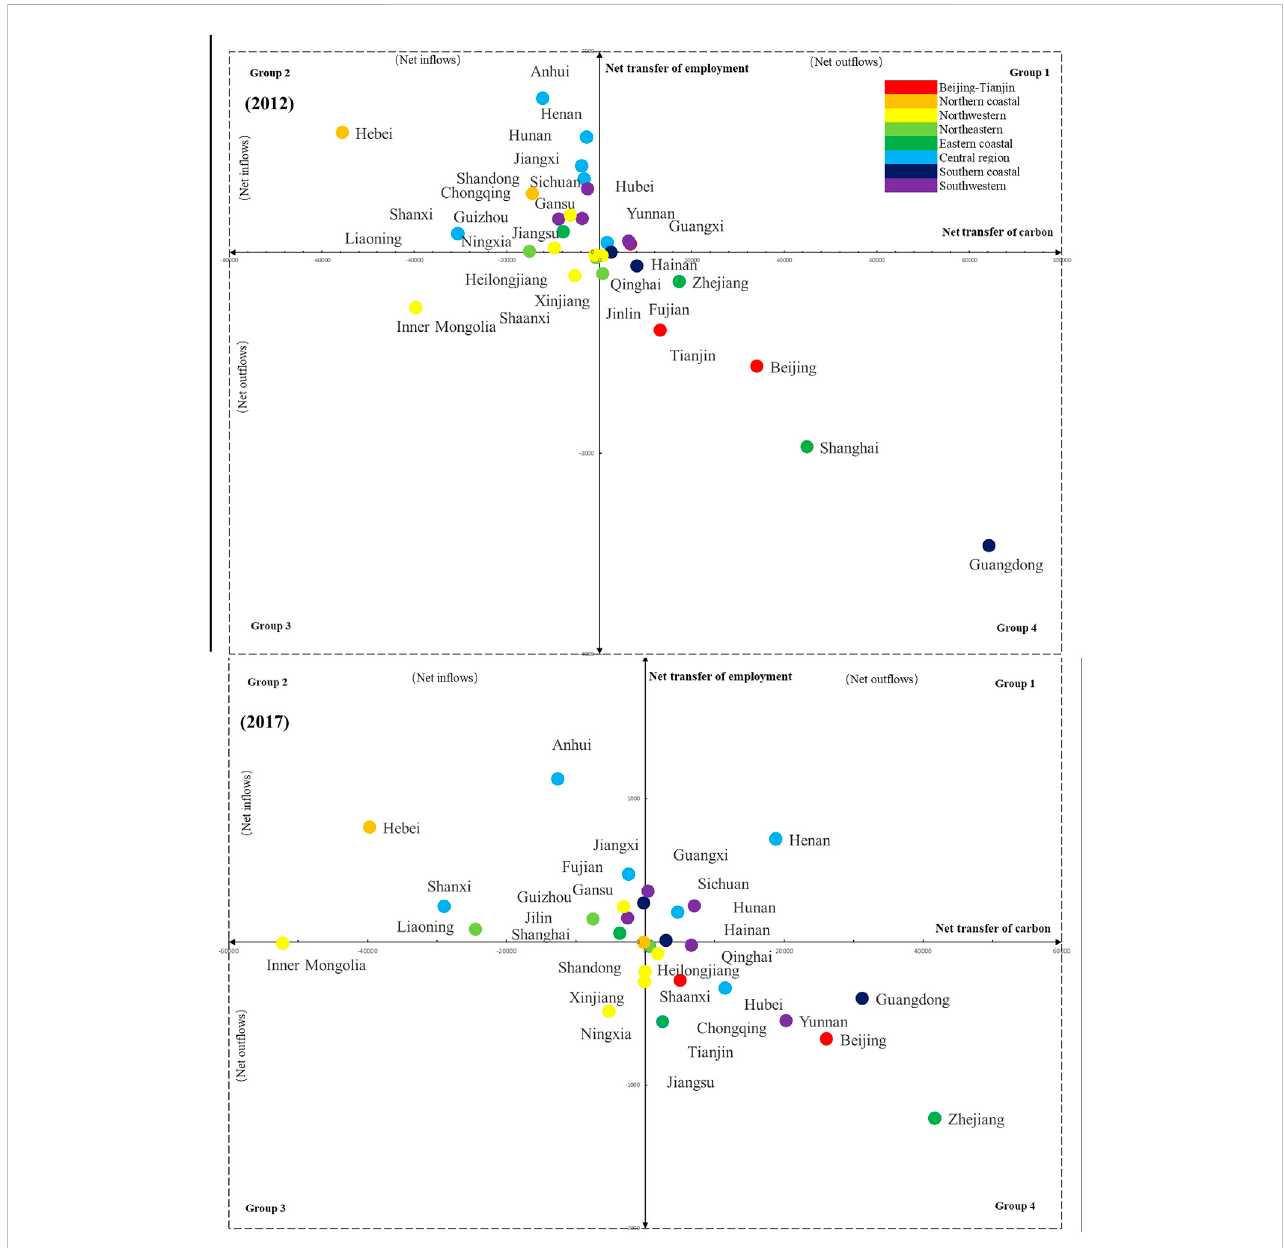
FIGURE 8 Net transfer Relationships between embodied carbon and embodied employment in the inter-provincial trade from 2012 to 2017.